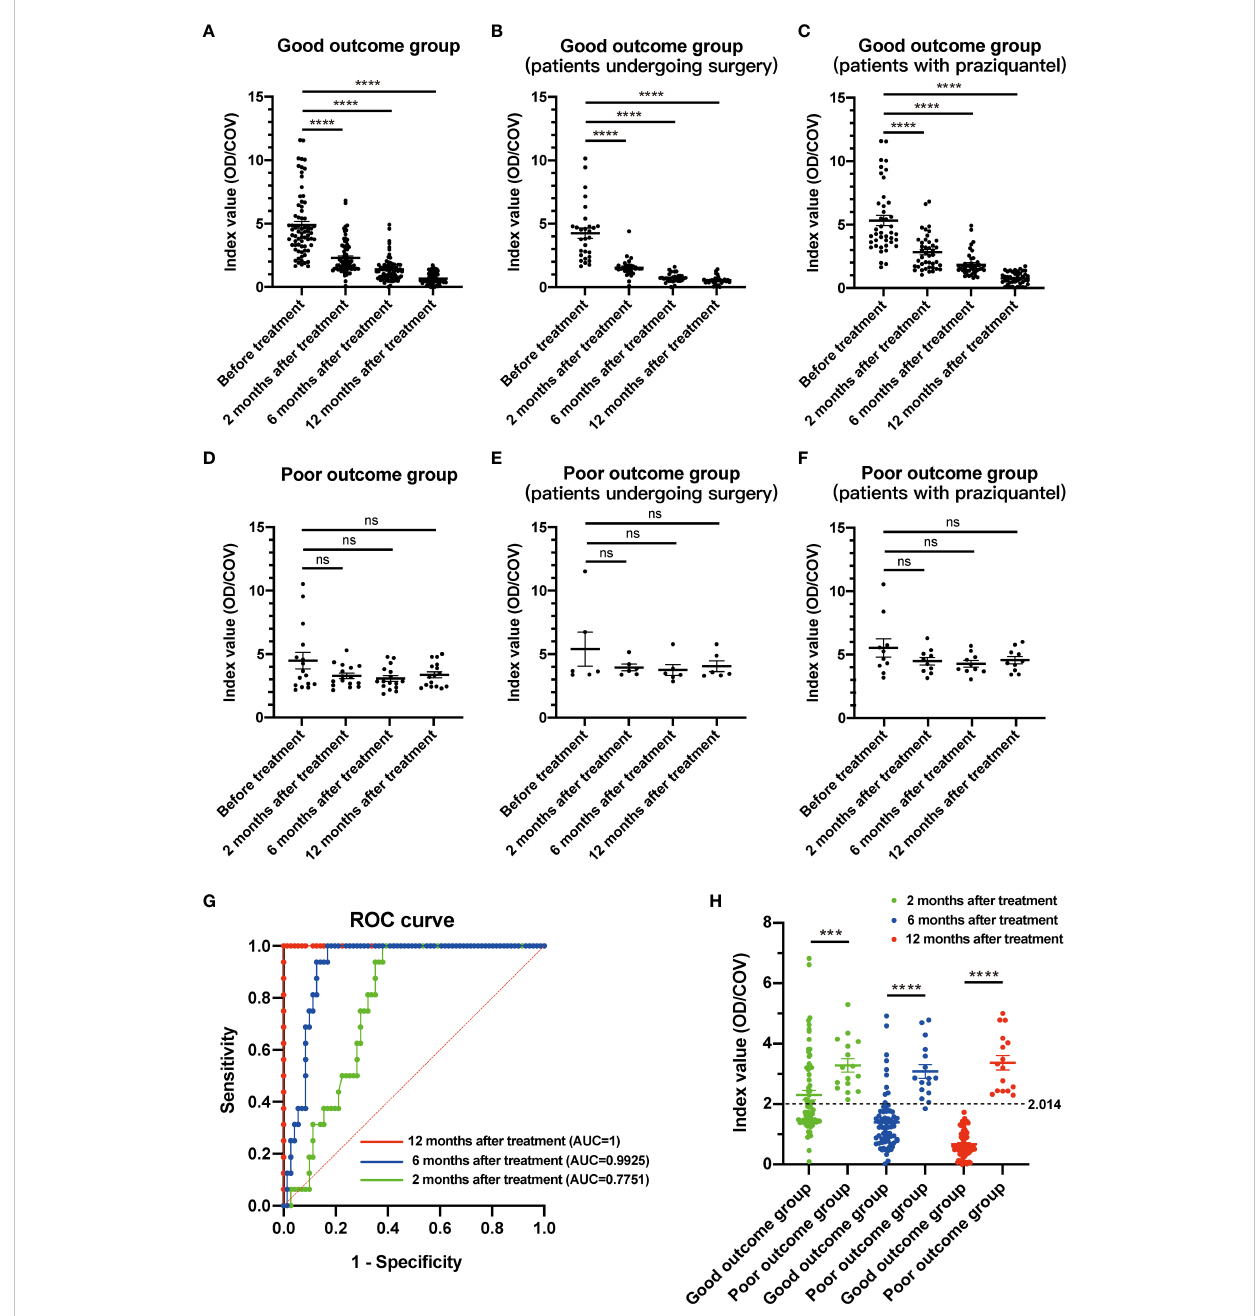
FIGURE 2 The index value changes of serological examination in patients with different clinical outcomes. (A) In the good-outcome group, the index value of IgG antibody showed signi fi cant decrease differences between before and after treatment. (B) In the good-outcome group of patients who underwent surgery, the index value of IgG antibody showed a signi fi cant decrease between before and after treatment. (C) In the good-outcome group of patients with praziquantel, the index value of IgG antibody showed a signi fi cant decrease between before and after treatment. (D) In the poor-outcome group, the index value of IgG antibody showed no signi fi cant differences between before and after treatment. (E) In the poor- outcome group of patients who underwent surgery, the index value of IgG antibody showed no signi fi cant differences between before and after treatment. (F) In the poor-outcome group of patients with praziquantel, the index value of IgG antibody showed no signi fi cant differences between before and after treatment. (G) The area under the curve (AUC) showed that the index value measured at 12 months after treatment had the best prediction effect. (H) In the good-outcome group, the index value of IgG antibody was less than 2.014 in all 71 patients at 12 months after treatment. In the poor outcome group, the index value was more than 2.014 in all 16 patients at 12 months after treatment. For all fi gures: one-way ANOVA with Tukey ’ s multiple comparisons test, ***p < 0.001; ****p < 0.0001; ns, no signi fi cant difference. Error bars indicate the